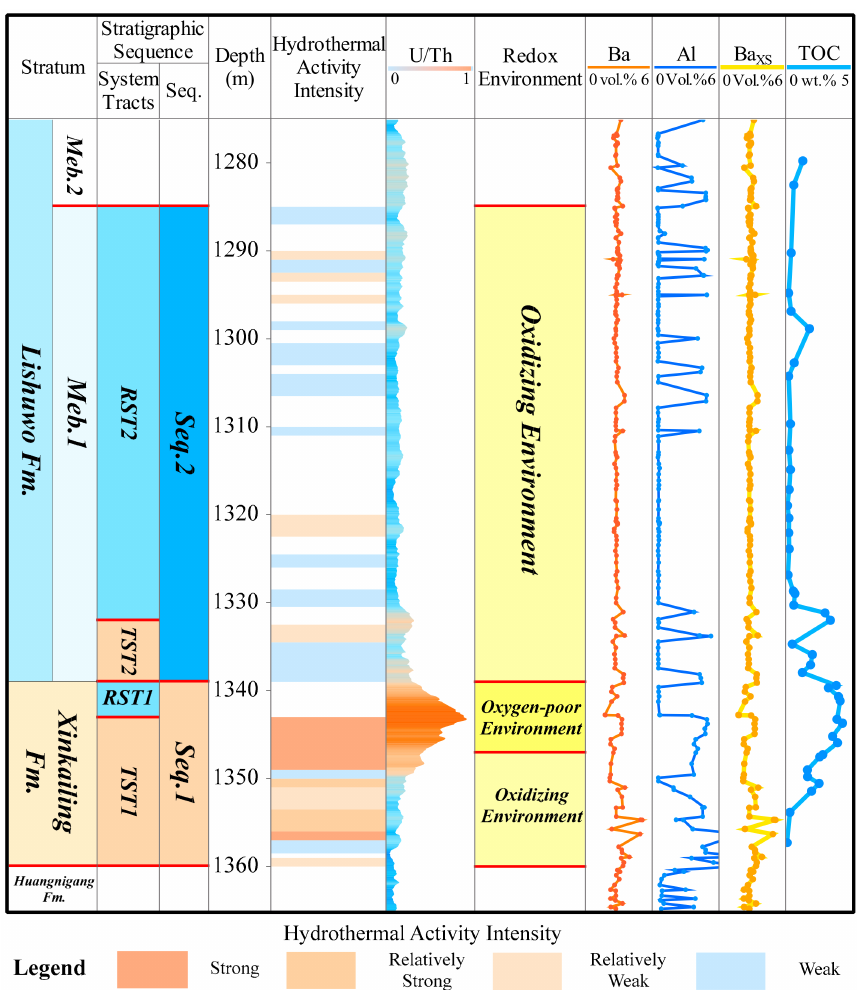
Figure 5. The influence of hydrothermal activity on organic matter enrichment of Xinkailing Fm.